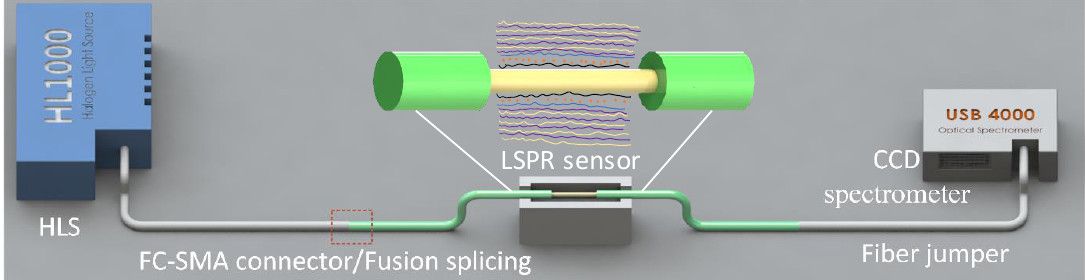
Figure 2. Experimental setup of solution refractive index sensing and heavy metal detection.